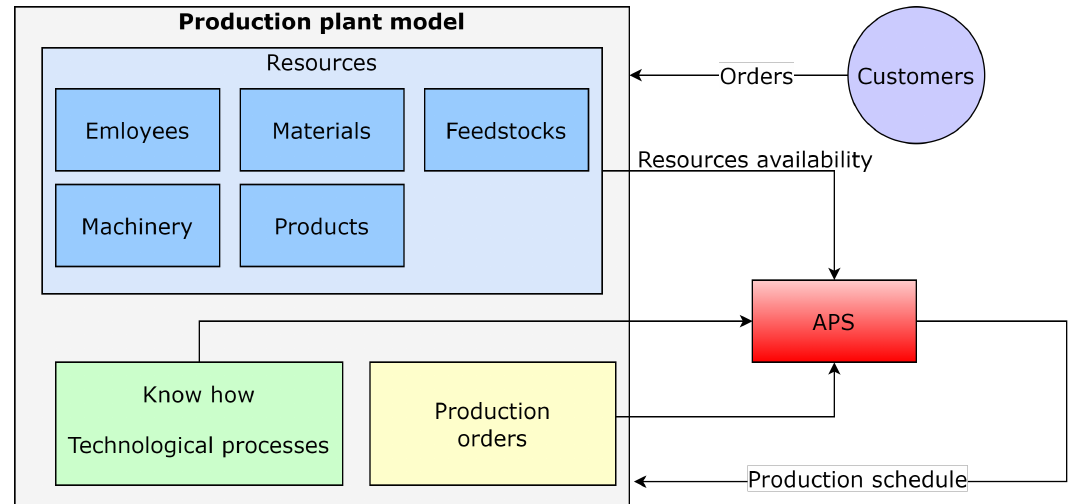
Figure 4. Model of the virtual production plant and its interaction with the APS system that imple- ments the methodology tested.